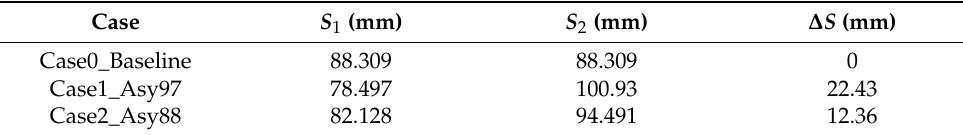
Table 5. Comparison of vane pitch for each case.